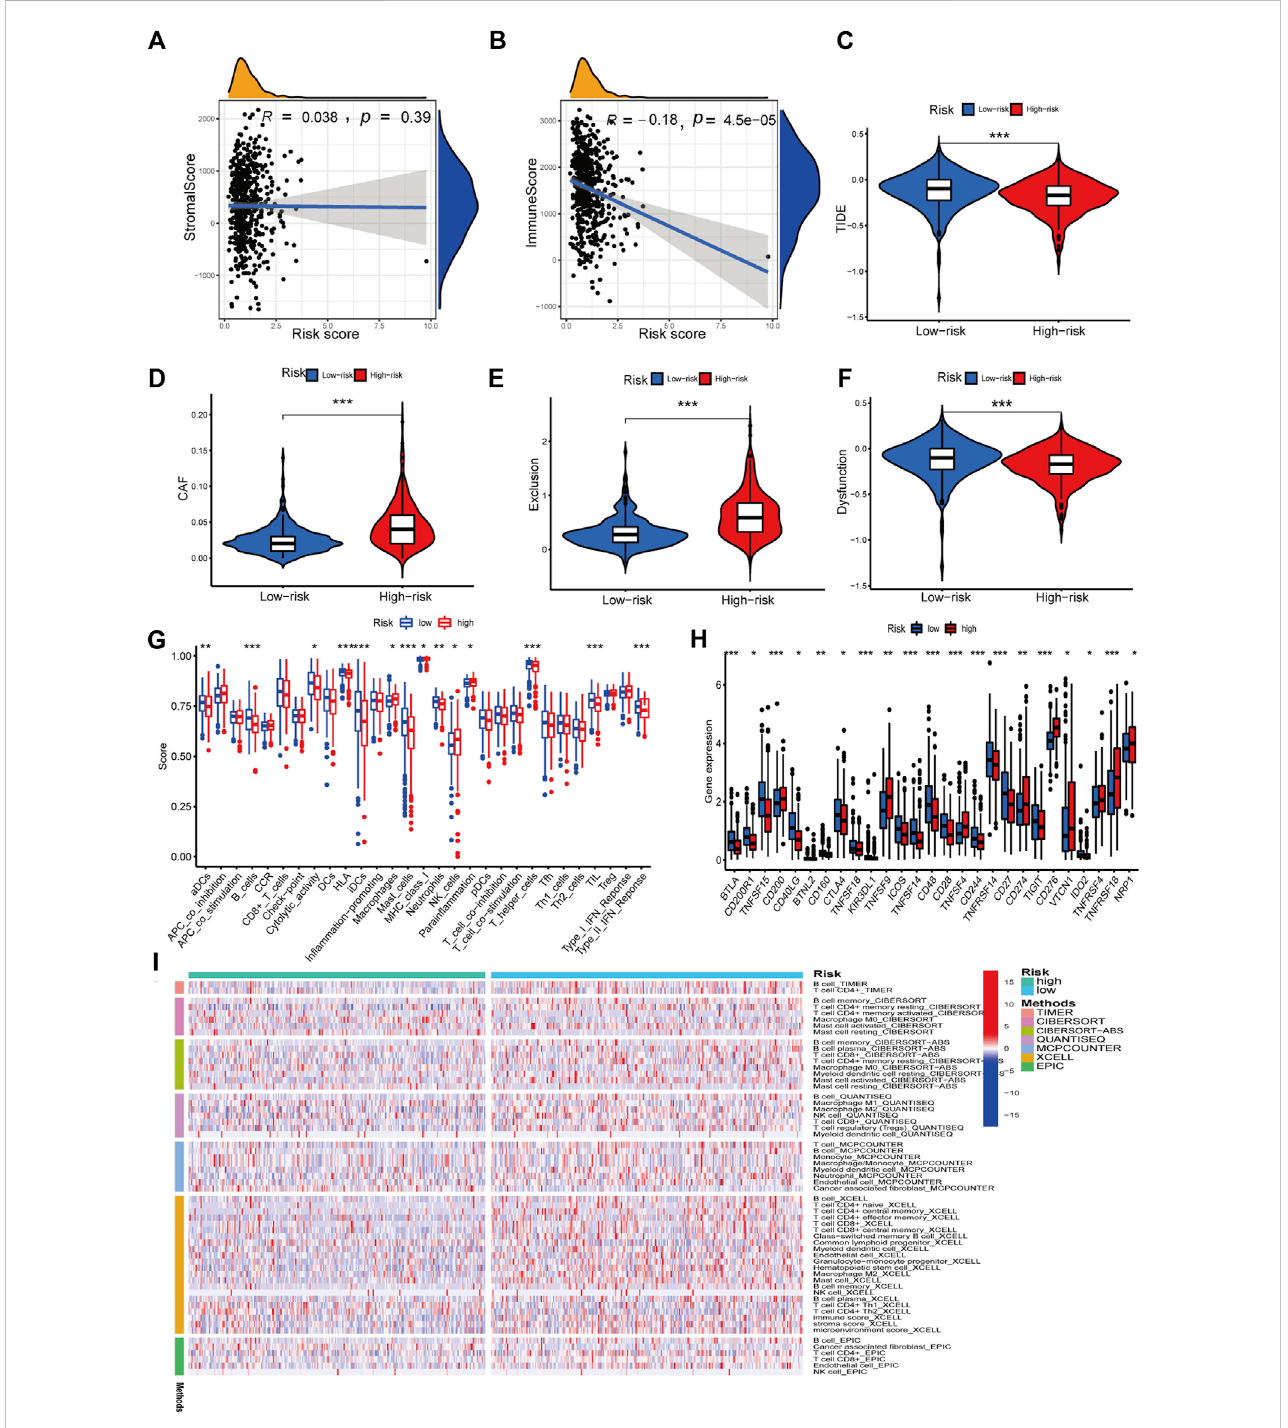
FIGURE 9 Immune features analysis. (A) Correlation analysis of the risk score and immune score. (B) Correlation analysis of the risk score and stromal score. (C) Comparison of TIDE and risk score. (D) Comparison of CAF and risk score. (E) Comparison of T-cell exclusion and risk score. (F) Comparison of T-cell dysfunctionandriskscore. (G) In fi ltrationscoreofimmunecells. (H) Expressionofimmunecheckpoints. (I) Heatmapofimmuneresponseinhighandlow-risk groups based on multiple algorithms. * p < 0.05, ** p < 0.01, *** p <